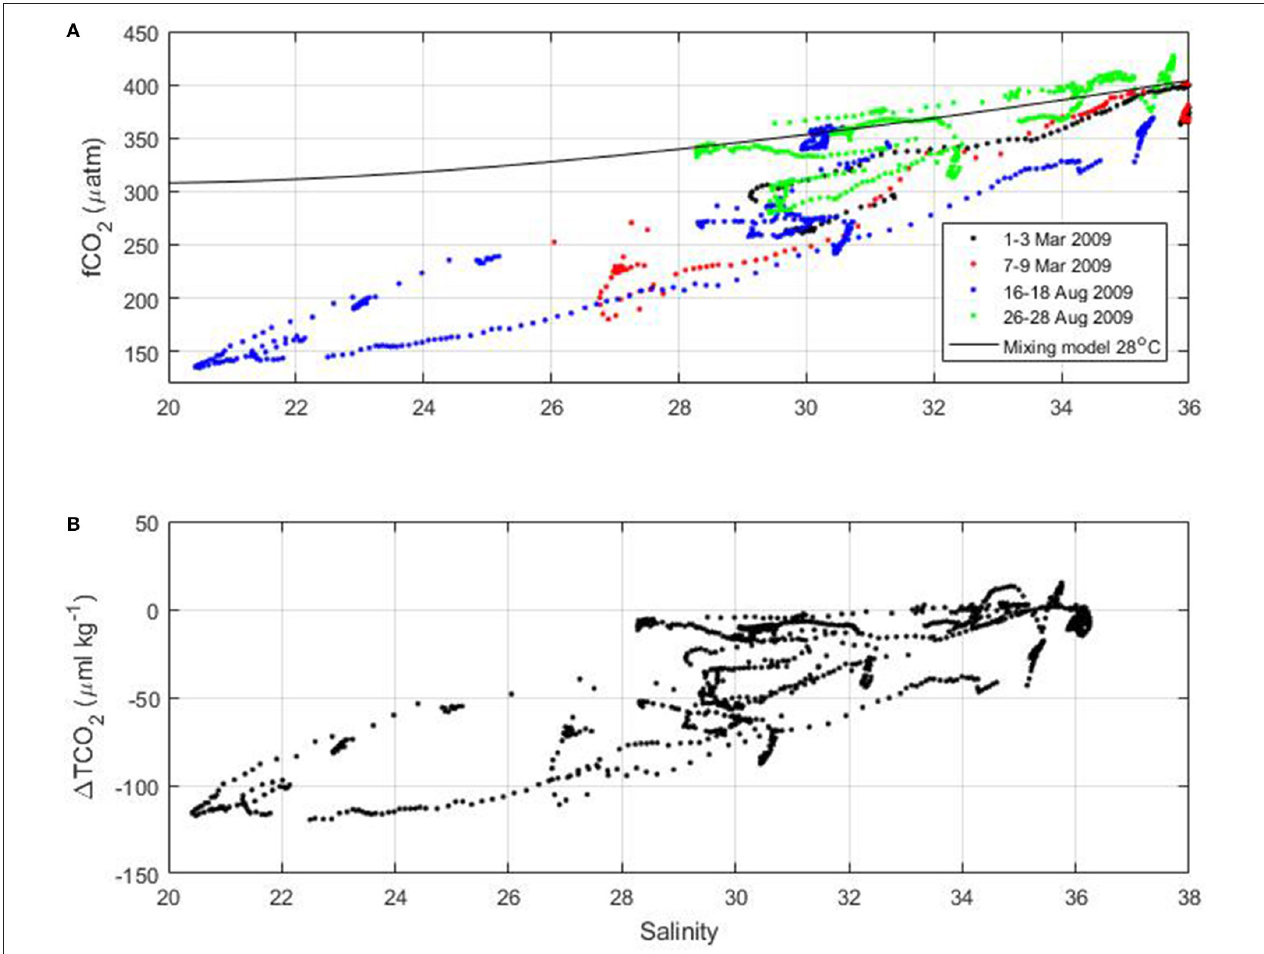
FIGURE 10 | (A) Surface fCO 2 of the MN Colibri cruises as a function of salinity. The mixing model at 28 ◦ C is indicated by the black line. (B) Difference of TCO 2 between the TCO 2 values calculated from fCO 2 and the mixing model as a function of